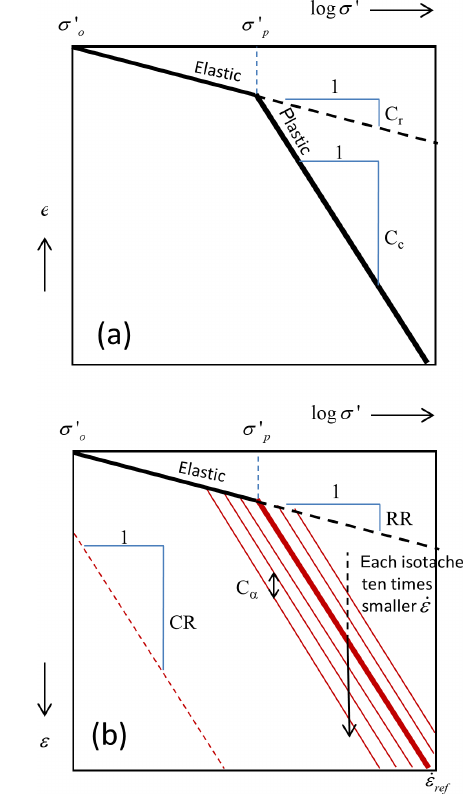
Figure 1. Comparison of the stress-deformation relations in (a) Terzaghi’s classical compression model (TM) and (b) the iso- tache model